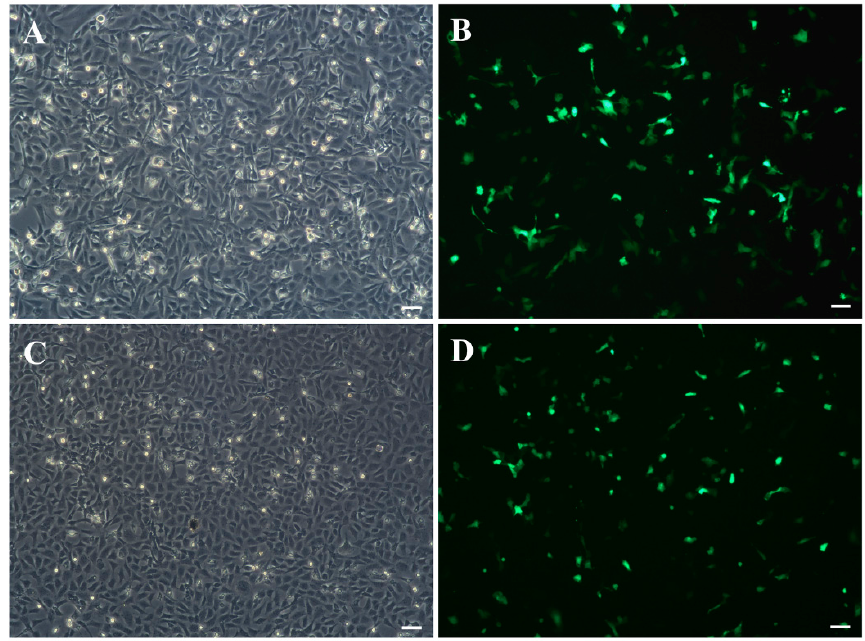
Figure 5. The expression of the GFP gene in JFSP cells 24 h after pEGFP-N1 transfection at passages 40 ( A , B ) and 80 ( C , D ). ( A , C ) Bright-field. ( B , D ) The expression of pEGFP-N1 in JFSP cells. Scale bar = 50 μ m. Scale bar = 50 µ